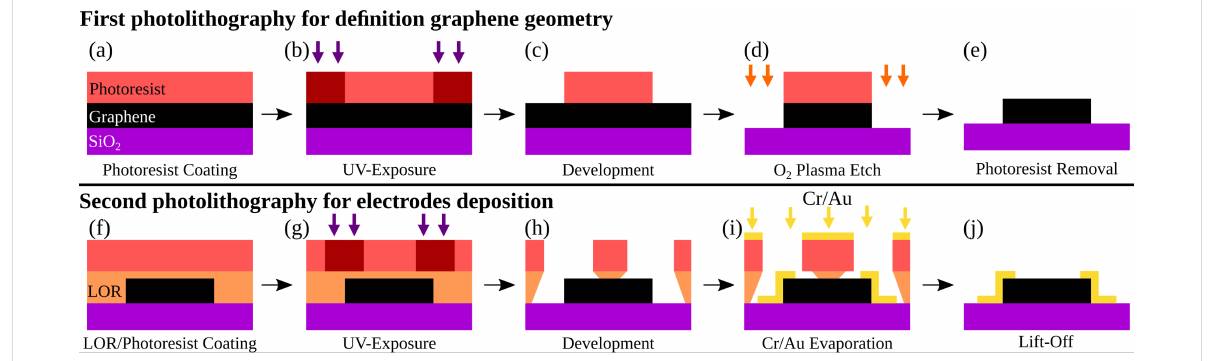
Figure 1: First photolithography step for the definition of the graphene structure: a) photoresist coating onto graphene; b) exposure of photoresist using direct laser writing; c) development of exposed areas; d) etching of graphene in O 2 plasma; e) photoresist removal. Second photolithography step for electrode fabrication: f) LOR/photoresist coating onto graphene; g) exposure of photoresist using direct laser writing; h) development of exposed areas; i) thermal evaporation of Cr/Au; j) lift-off